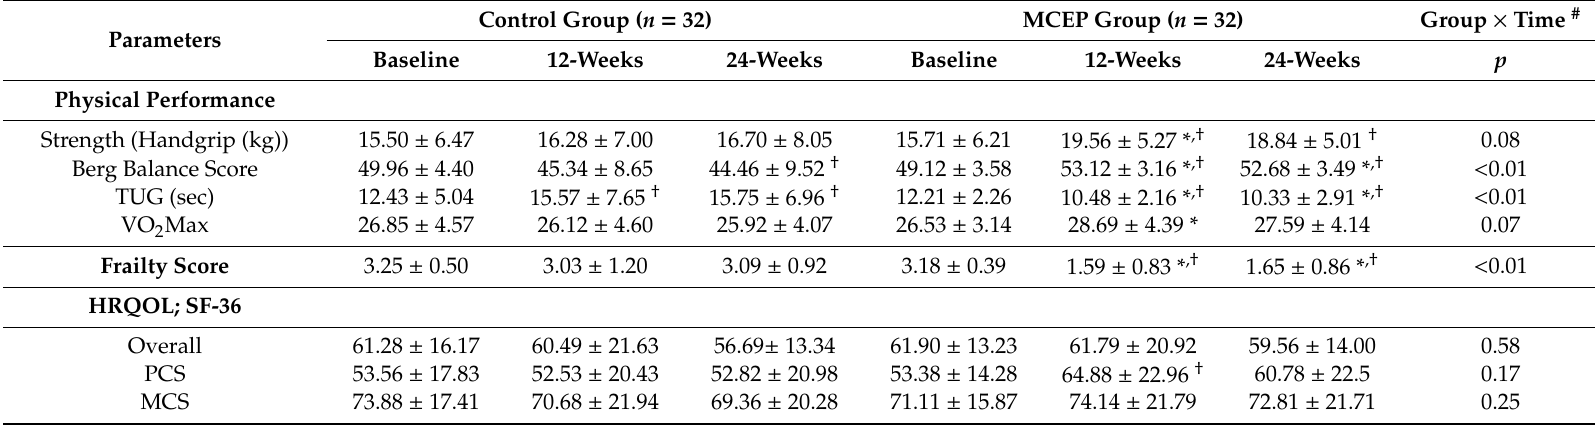
Table 3. Comparisons of outcome between groups in physical performance, frailty score and HRQOL at baseline, 12 and 24